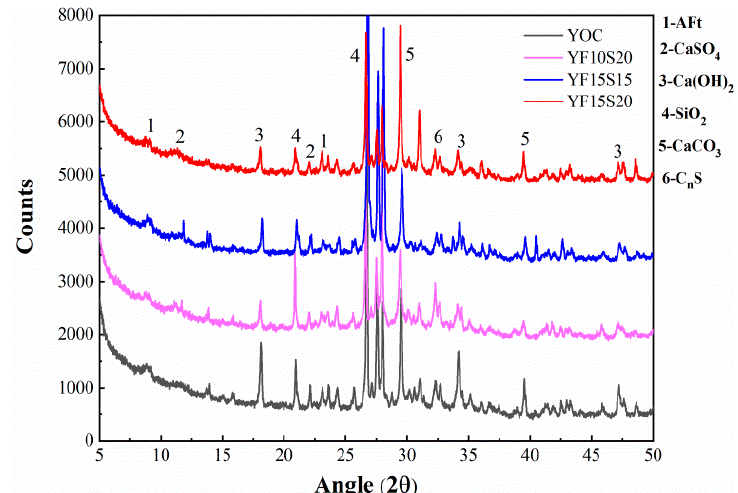
Figure 12. XRD pattern of concrete on the 28th